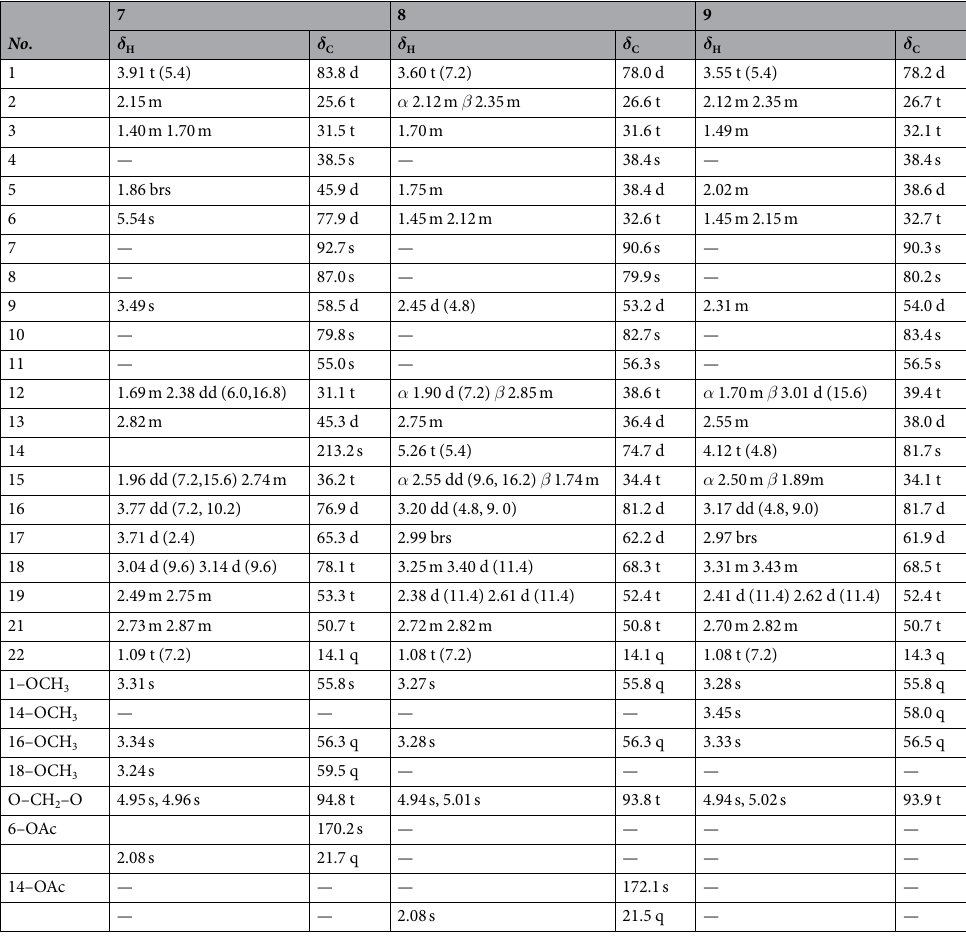
Table 3. NMR Spectroscopic Data a for Compounds 7 – 9 (600 MHz for 1 H, 150 MHz for 13 C, CDCl 3, δ ppm). a Data are based on DEPT, HMQC, and HMBC